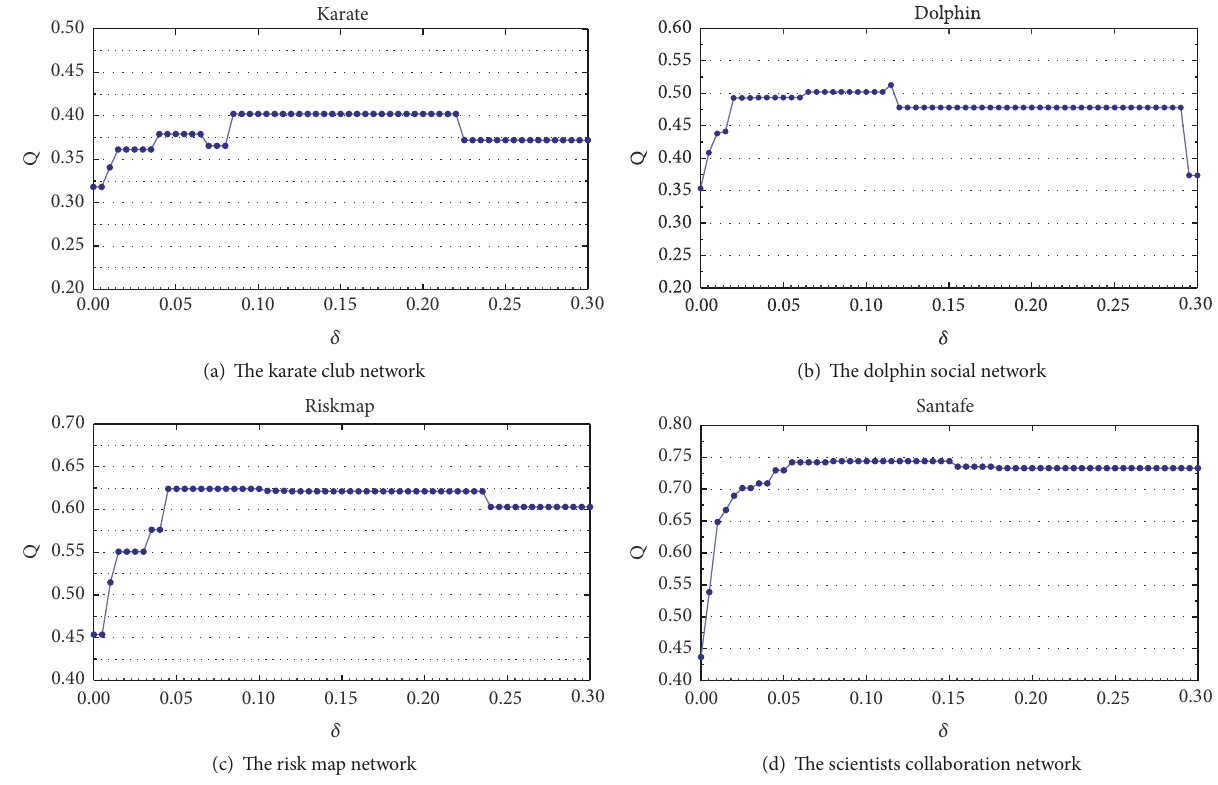
Figure 9: The setting of parameter 𝛿